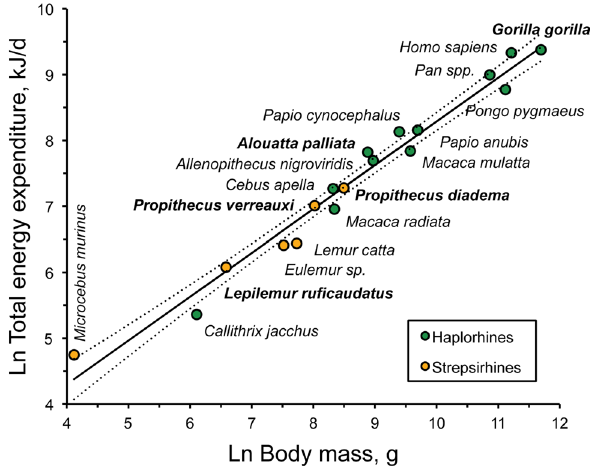
Figure 1. Scaling of energy expenditure with body mass among strepsirhine and haplorhine species after logarithmic transformation of the data. Species with a folivorous tendency are identified in bold. In this PGLS regression analysis, the equation is LnDEE (kJ/d) = 1.64 (± 0.24) + 0.66 (± 0.03) * LnBody mass (g), with 97% of the DEE variance explained by body mass